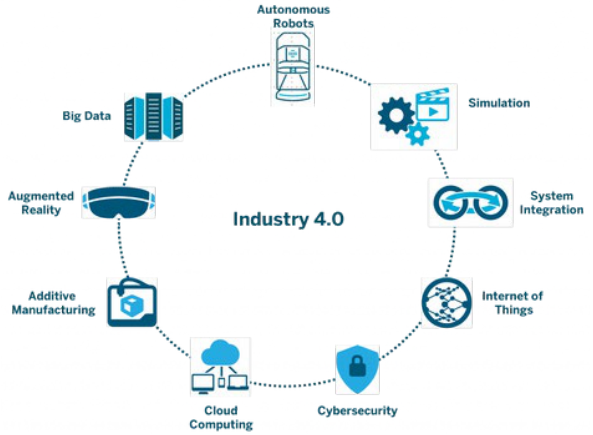
Fig. 1. Technologies and tools of Industry